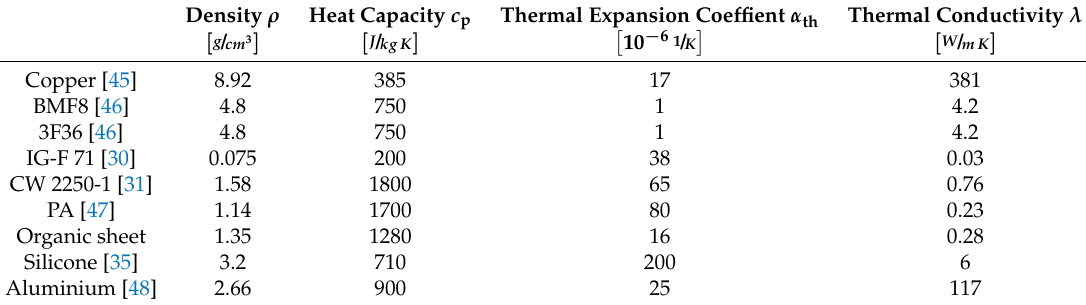
Table 4. Material parameters of the thermal simulation